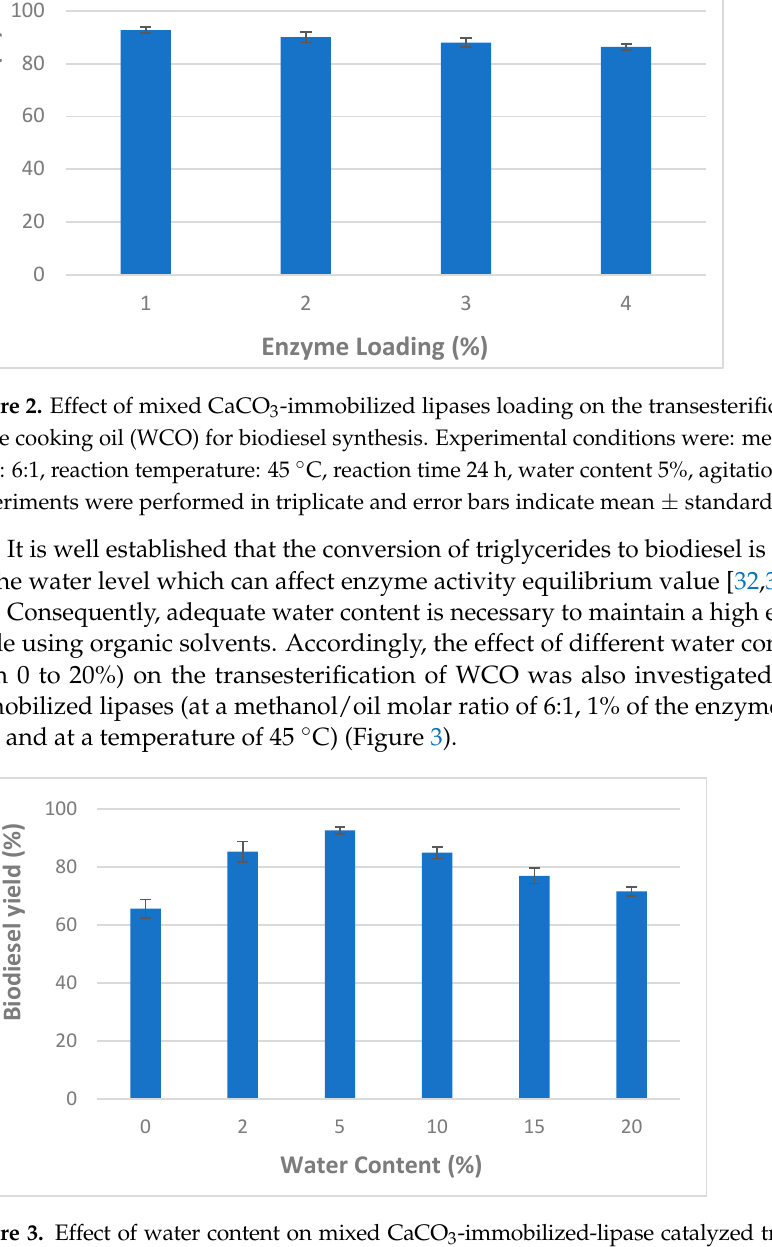
Figure 3. Effect of water content on mixed CaCO 3 -immobilized-lipase catalyzed transesterification process of waste cooking oil (WCO) for biodiesel synthesis. Experimental conditions were: metha- nol/oil molar ratio: 6:1, lipase loading 1%, reaction temperature: 45 °C, reaction time 24 h, agitation speed 150 rpm. Experiments were performed in triplicate and error bars indicate mean ± standard deviation.